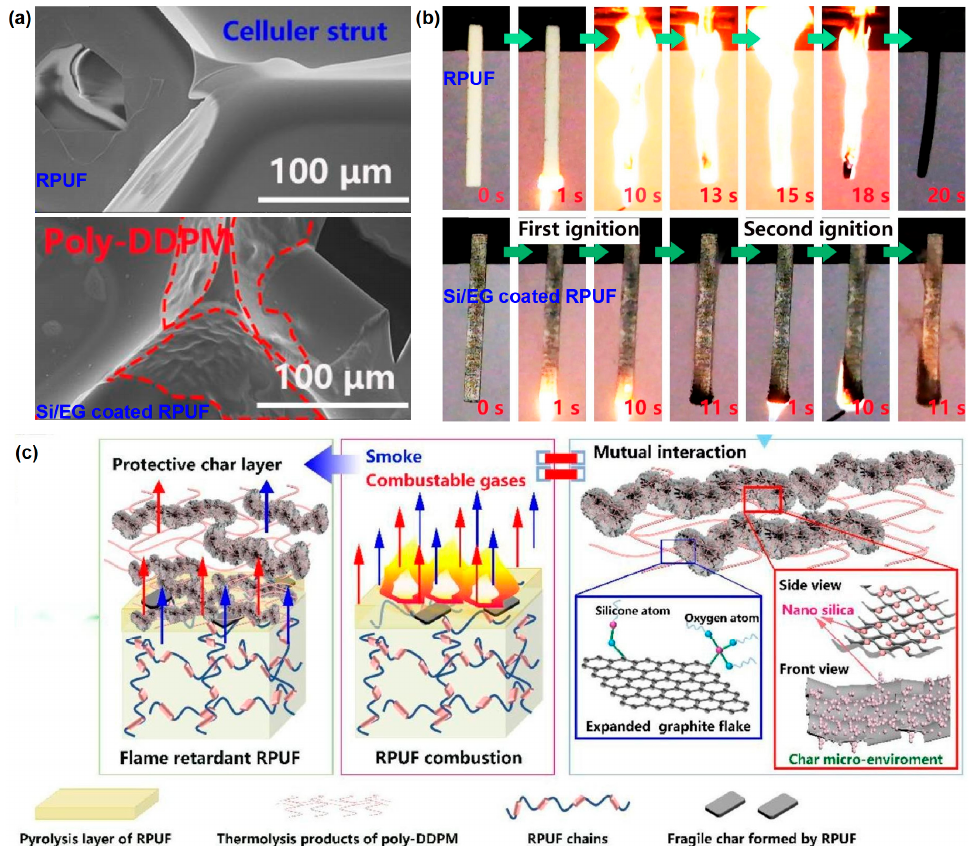
Figure 8. ( a ) Surface SEM images of pure RPUF and the coated RPUF samples, ( b ) optical photos of samples in UL-94 testing, and ( c ) flame-retardant mechanism schematic diagram of the RPUF with Si/EG coating [33].